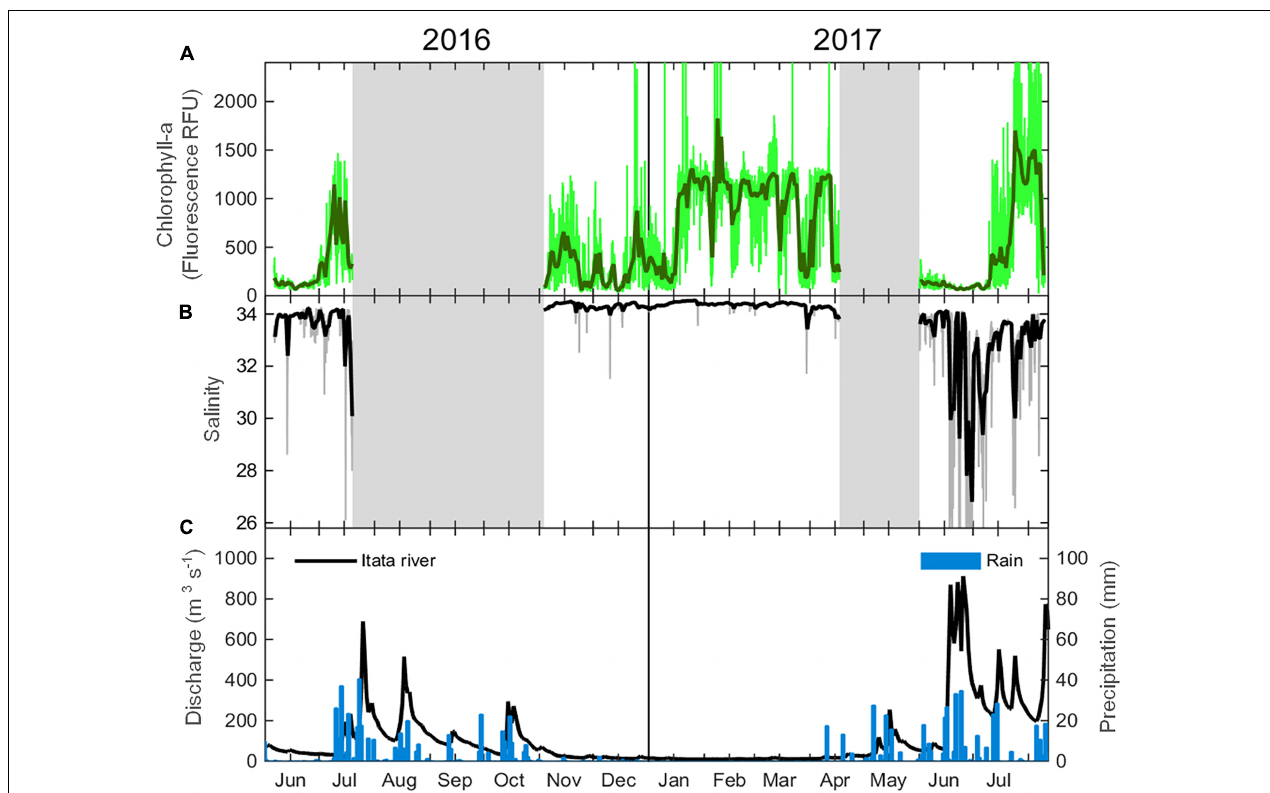
FIGURE 7 | Daily mean (thick lines) and hourly (thin lines) variability of (A) phytoplankton biomass (as fluorescence of chlorophyll in RFU) and (B) salinity captured by POSAR, an automated monitoring buoy located at ∼ 10 km off the mouth of Itata River (see Figure 1 ), compared to (C) daily Itata river discharge (m 3 s − 1 ) and precipitation (mm) during 2016 to 2017 period (01 June 2016 to 10 August